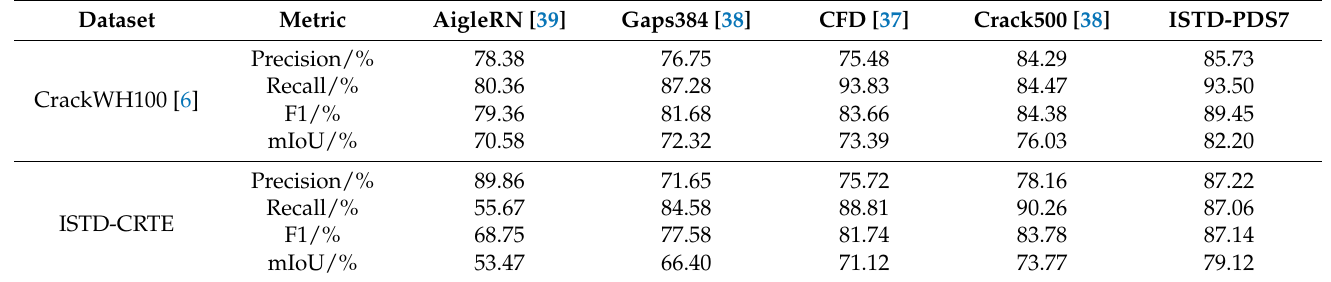
Table 5. Performance comparison for SegFormer trained on the different